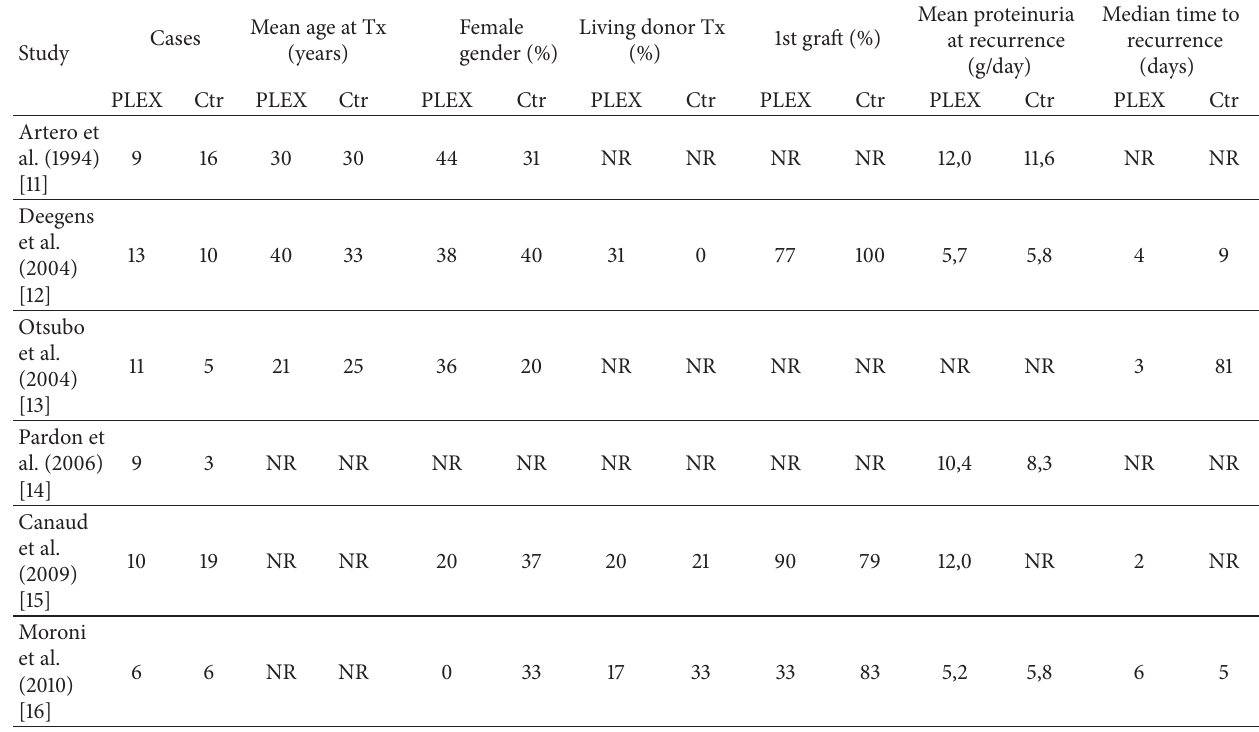
Figure 1: Flow diagram of systematic literature search. FSGS: focal segmental glomerulosclerosis. Table 1: Characteristics of cases in included studies. Ctr: control group; NR: not reported; PLEX: plasma exchange group; Tx: